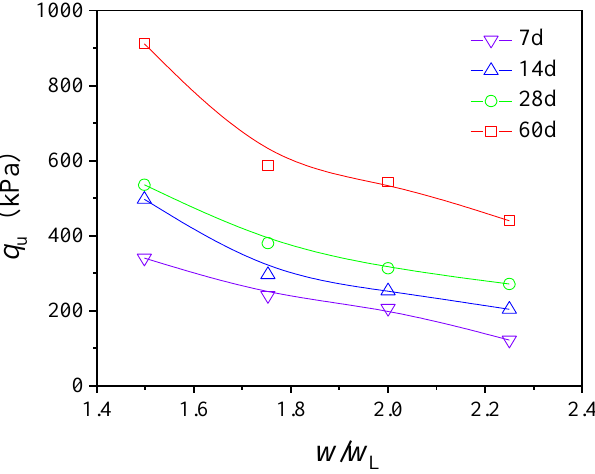
Figure 2. Relationship of q u - w / w L ( T = 18 °C, A w = 15%, C o = 3.7%).